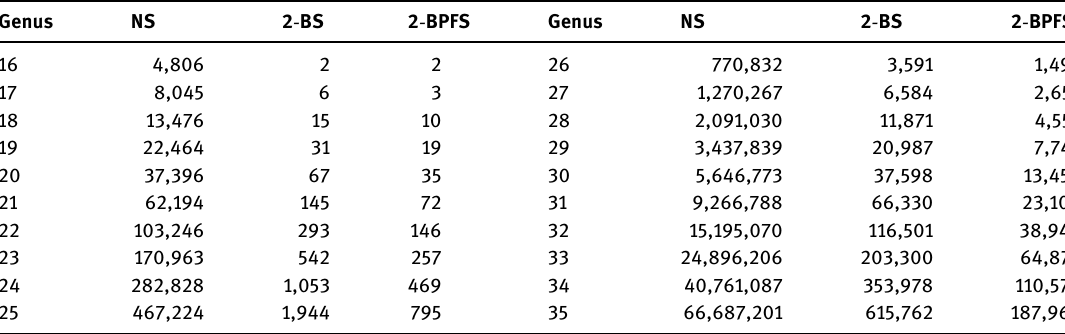
Table 1: Number of numerical semigroups ( NS ) and 2 - Buchweitz semigroups ( 2 - BS ) compared with number of 2 - Buchweitz PF - semigroups ( 2 - BPFS ) up to genus 35